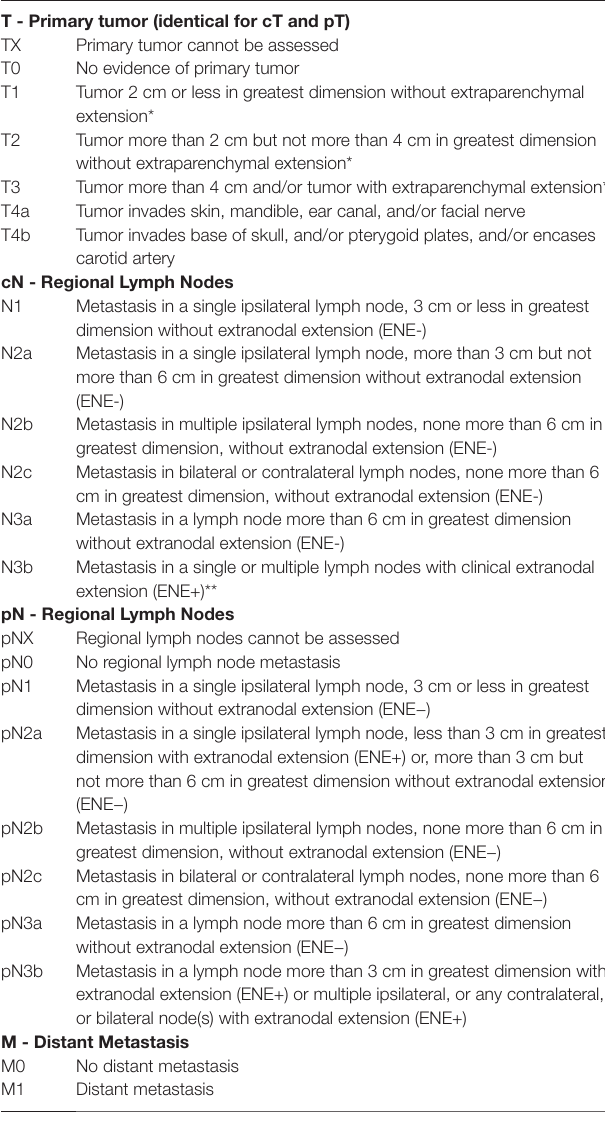
TABle 2 | TNM Classification of parotid